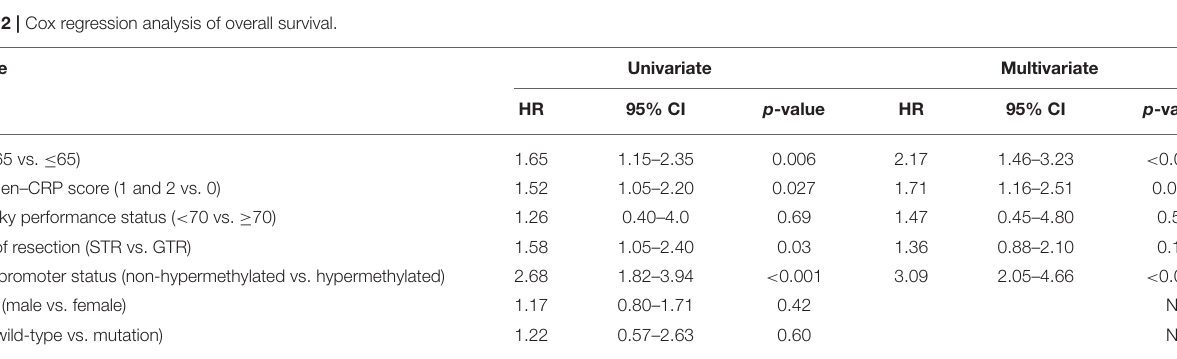
TABLE 2 | Cox regression analysis of overall